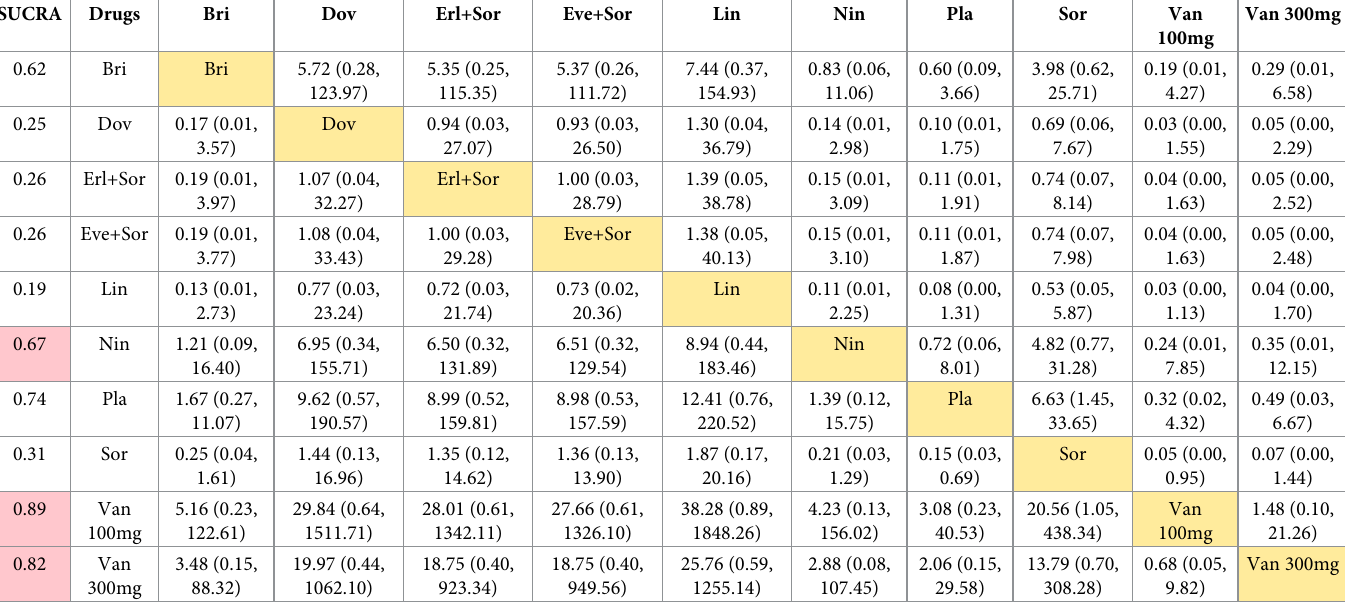
comparisons (S3, S8, S11 and S14 Figs). Though application of a fixed-effect model would pro- vide similar numerical results with shorter credible intervals, random-effect model was more appropriate according to the residual deviance and DIC criteria (S2 Table). There was no obvi- ous asymmetry at visual inspection of funnel plots to suggest publication bias as shown in S16 Fig. According to GRADE approach, the direct, indirect, and NMA Estimates for OS and G3- 5AE were shown in S4 and S5 Tables. The quality of the most evidence was low. Table 6. Network meta-analyses for G3-5AE (Findings are expressed as OR (95% CrI), use of random-effect model). SUCRA